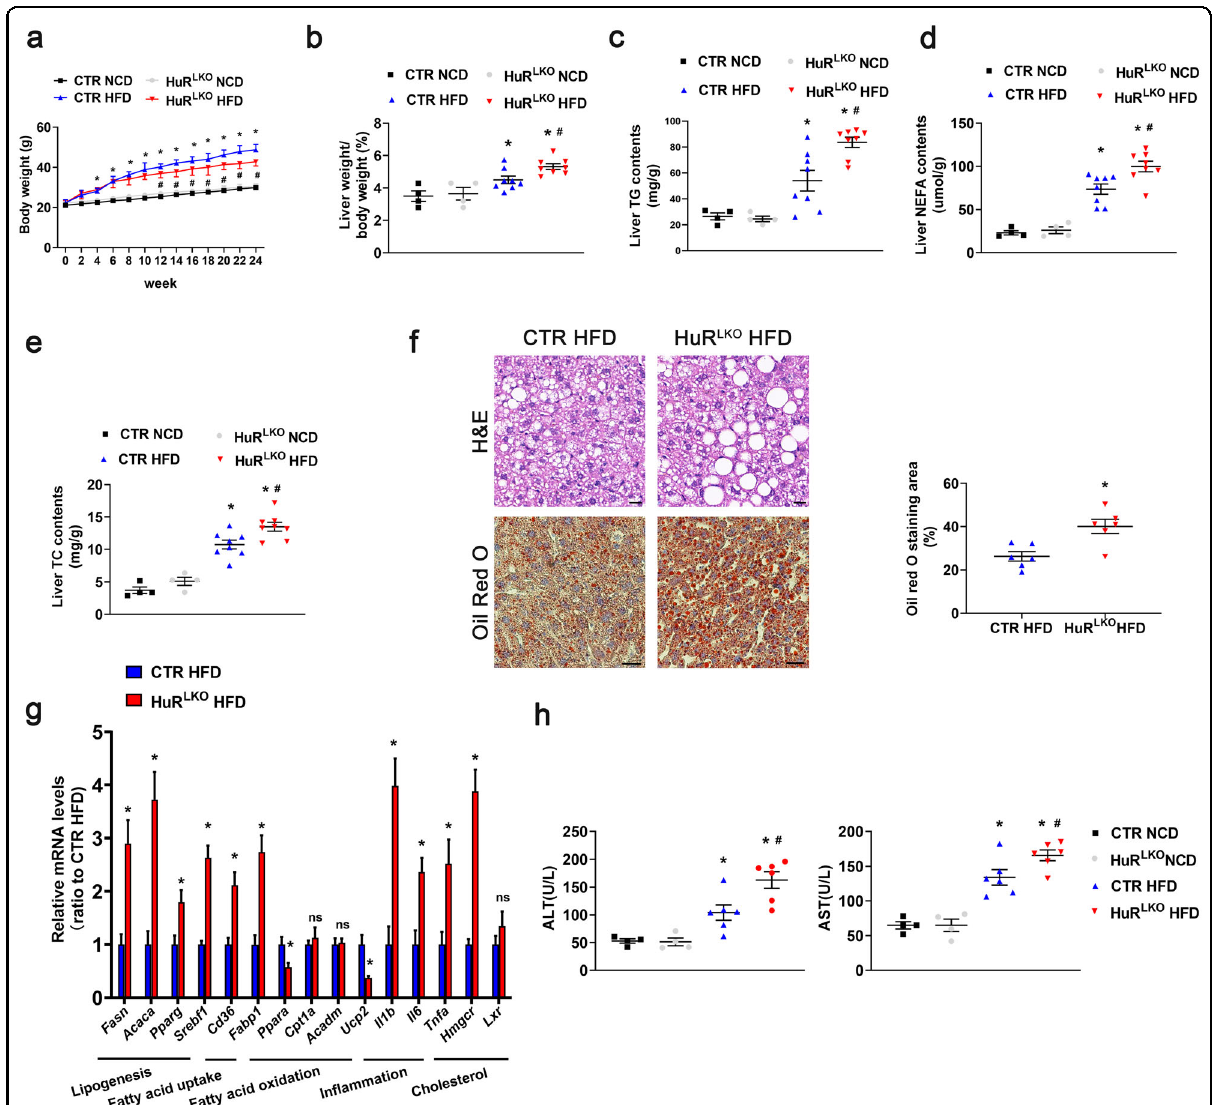
Fig. 2 Liver-speci fi c HuR deletion aggravated HFD-induced hepatic steatosis. Control and HuR LKO mice were fed a NCD or HFD for 24 weeks. a Body weight of mice in different groups ( n = 8). * P < 0.05 vs CTR NCD, # P < 0.05 vs CTR HFD. b Liver weight to body weight ratio of mice in different groups ( n = 8). * P < 0.05 vs CTR NCD, # P < 0.05 vs CTR HFD. Triglycerides (TG) ( c ), nonesteri fi ed fatty acid (NEFA) ( d ), and cholesterol (TC) ( e ) levels in the liver of mice ( n = 8). * P < 0.05 vs CTR NC, # P < 0.05 vs CTR HFD. f H&E-stained (top) and Oil Red O-stained (bottom) liver sections from mice. Scale bar, 20 μ m. Quantitative analysis (right) of the mean Oil-red O-stained area ( n = 6). * P < 0.05 vs CTR HFD. g Relative mRNA levels of indicated molecules in the liver of mice ( n = 5). * P < 0.05 vs CTR HFD. h Serum ALT and AST levels ( n = 6). * P < 0.05 vs CTR NCD, # P < 0.05 vs CTR